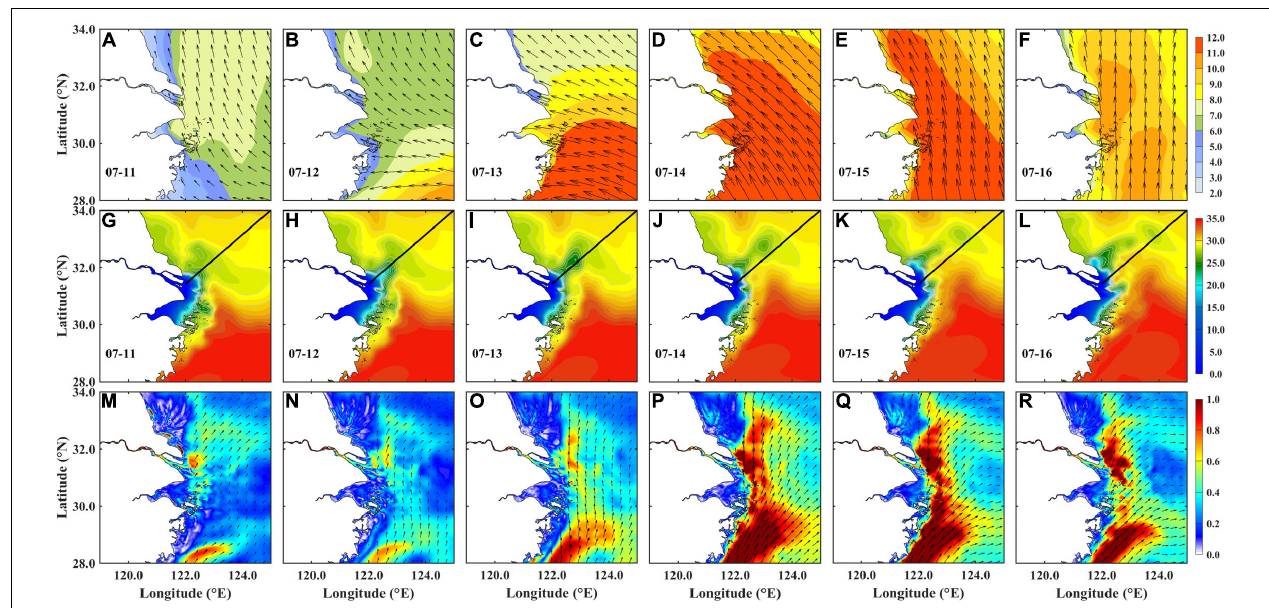
FIGURE 6 | The daily-averaged (A–F) wind (unit: ms − 1 ), (G–L) surface salinity, and (M–R) surface current (unit: ms − 1 ) from July 11 to 16, 2006 in Exp1. The black line indicates the cross-section A; color indicates magnitude and arrow for direction.